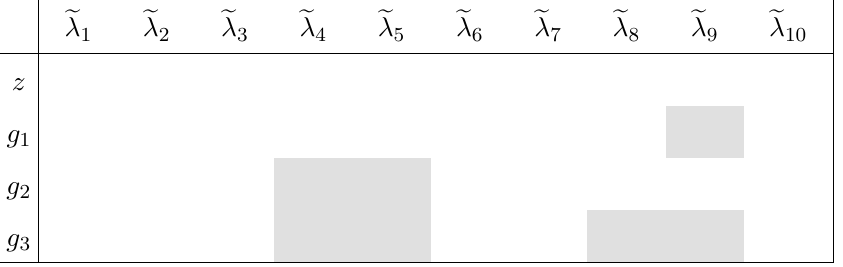
Table 2 . Dependence of the e (cid:21) i ’s on the higher dimensional coupling constants. Shaded entries denote that the dependence of the e (cid:21) i parameter on the corresponding coupling constant